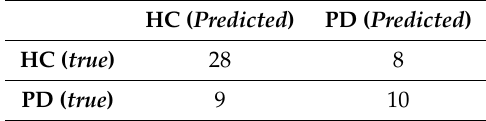
Table 8. Confusion matrix for the ensemble of the best three